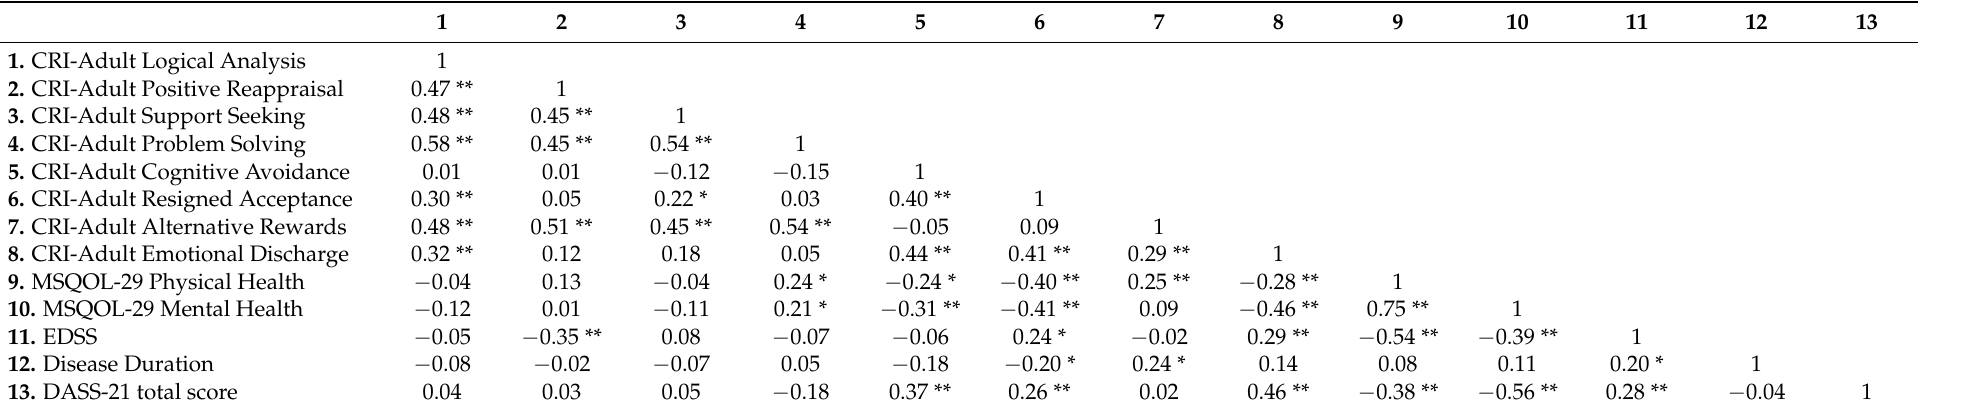
Table 1. Pearson’s correlations between CRI-Adult subscales, MSQoL-29 physical and mental health composite scores, EDSS, and disease